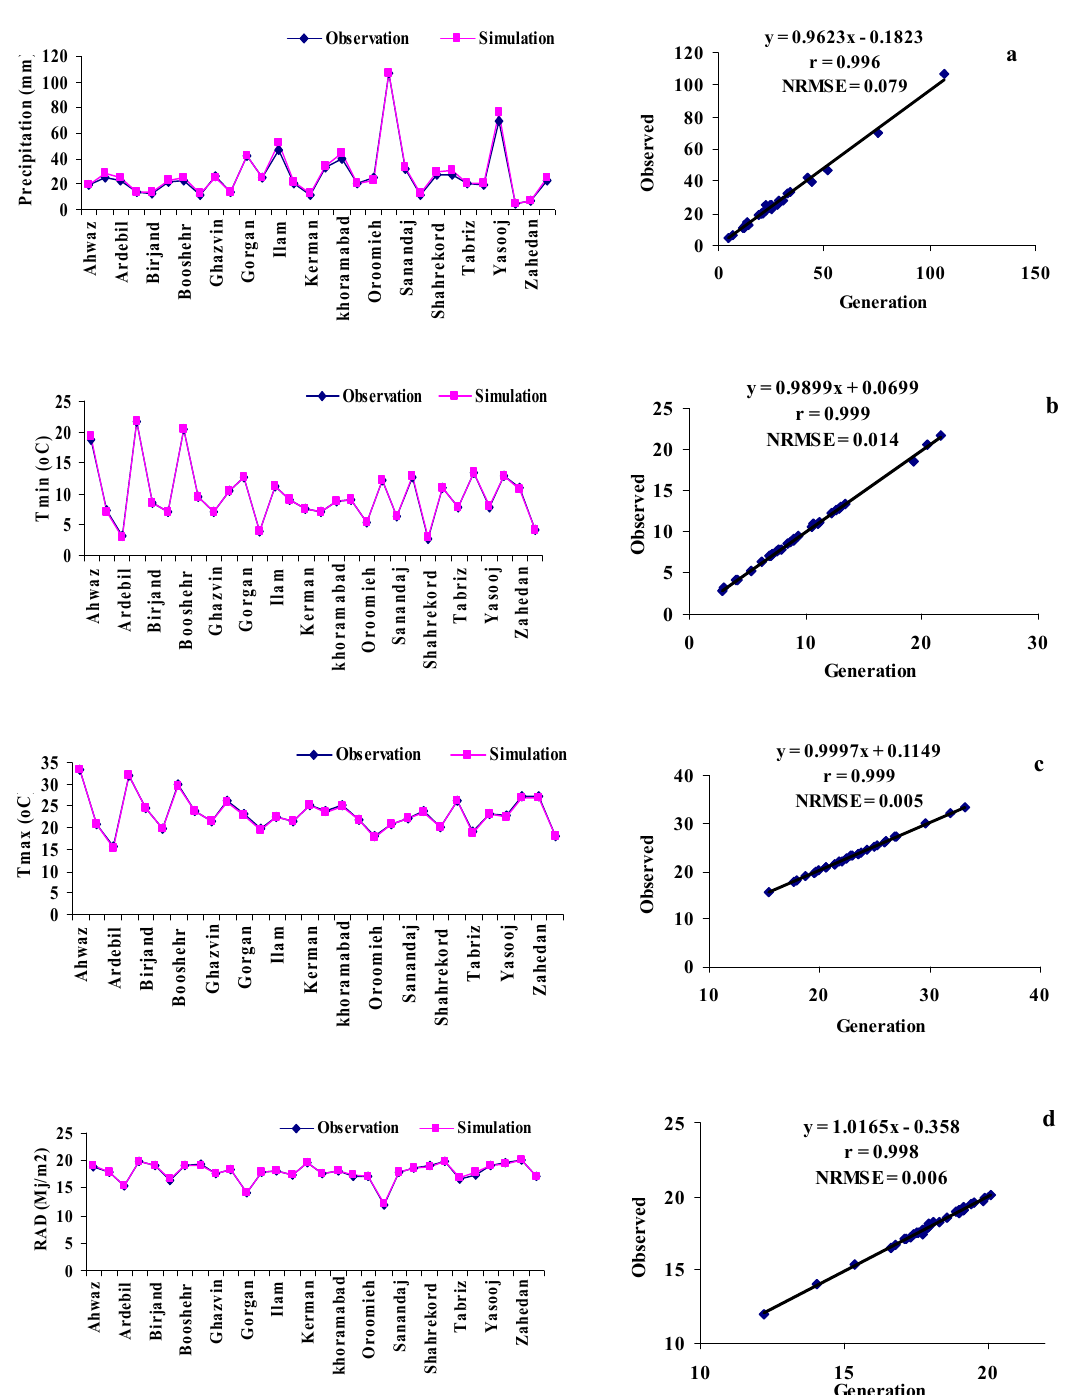
Figure 2. The results of LARS-WG calibration in the prediction of weather variables in the base period. ( a = precipitation, b = Tmin, c = Tmax, d = Radiation) The result of Figure 3 shows that the ET 0 values in the northern half of the country are less than the southern half. So that the ET 0 ranges from 2.71 to 3.02 in the northern half while in the southern half, it varies from 3.53 to 4.79.